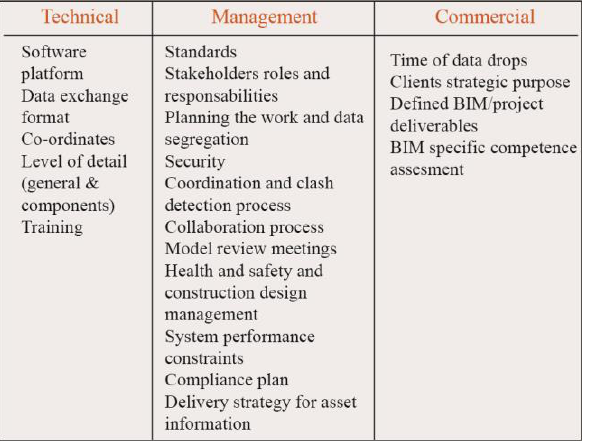
Figure 1. The table sets out the typical contents of an